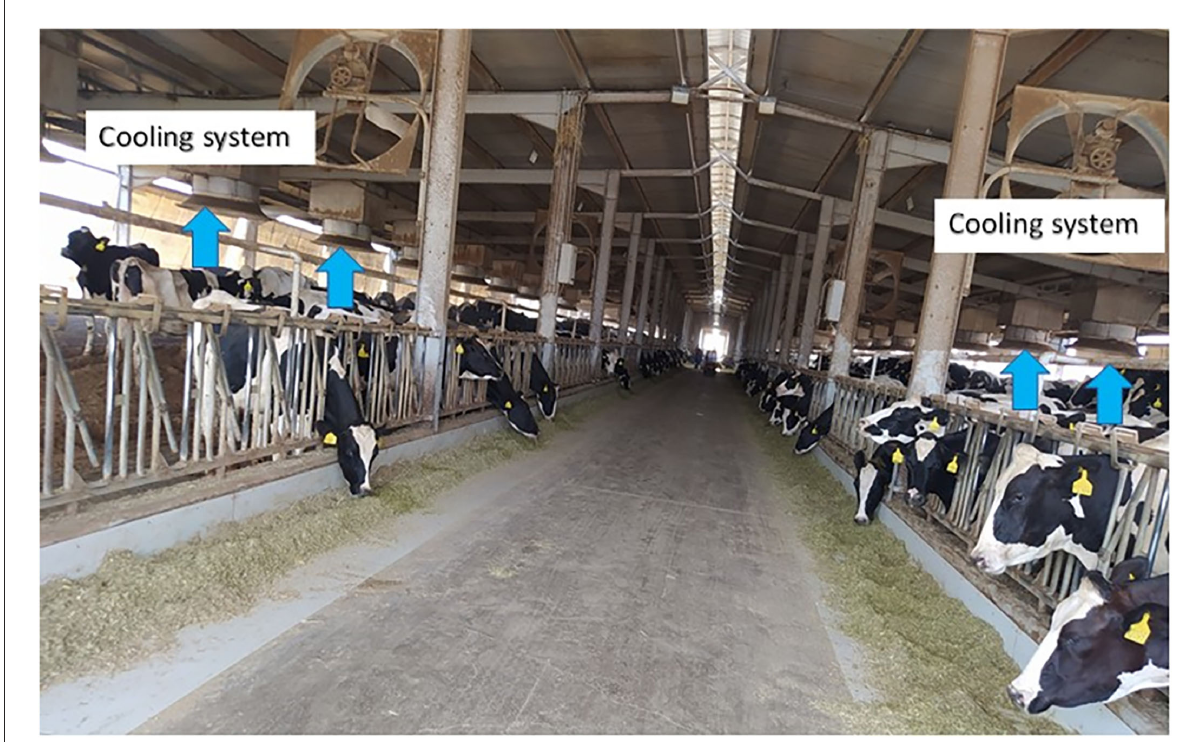
FIGURE1 One of the barns of the National Dairy Farm. The barns are open with shades while the floor is sandy. The arrows indicate the in-built cooling system. Most of the ingredients of the feed including hay are imported from other countries.